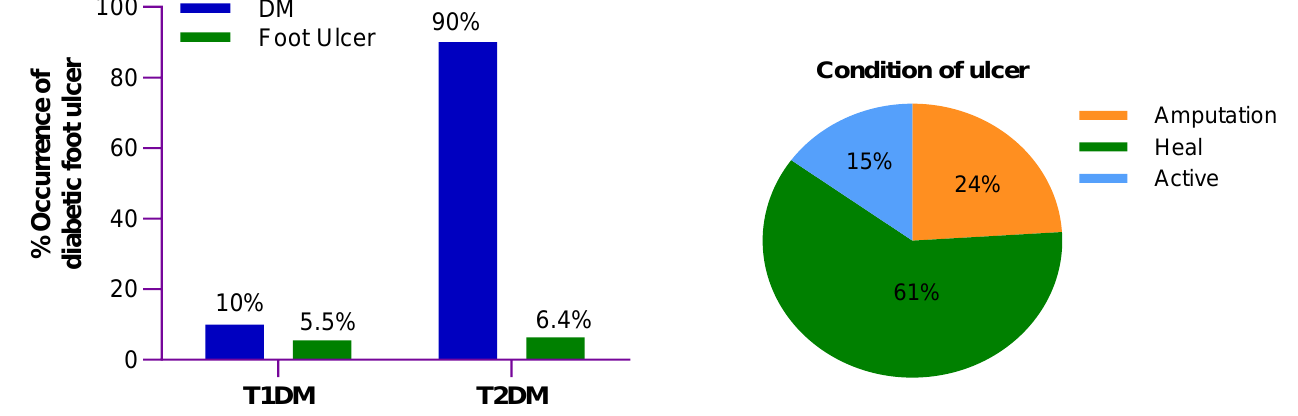
Figure 1. Incidence rates of diabetic foot ulcers in T1DM and T2DM and their conditions. More than 85% of all amputations in diabetic foot patients are preceded by ulceration leading to severe gangrene or infection [12,25]. On average, about 6.4% of the worldwide population suffers from diabetic foot, with 2 to 5% yearly occurrence rates of ulcer or necrosis [26]. It is predicted that 19 to 34% of diabetic individuals will encounter foot disease at some stage in their lives [23]. A systemic meta-analytical review has shown that diabetic foot ulcers (DFU) are more common in men (4.5%) than in women (3.5%) and more prevalent in type 2 diabetic patients (6.4%) compared to type 1 individuals